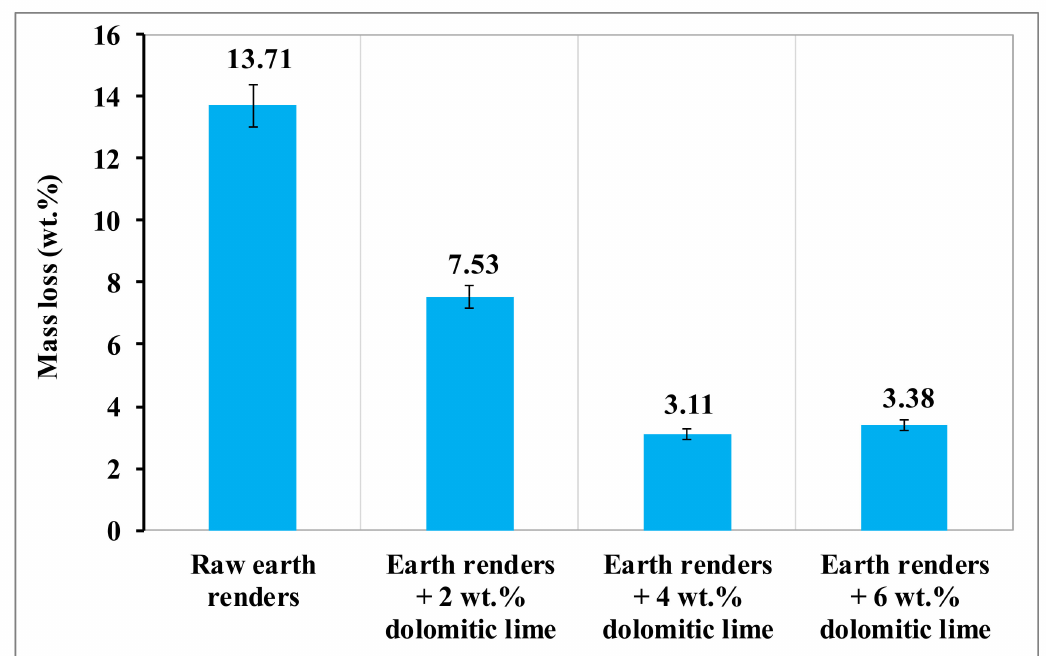
Figure 10. Mass loss of earth renders with dolomitic lime